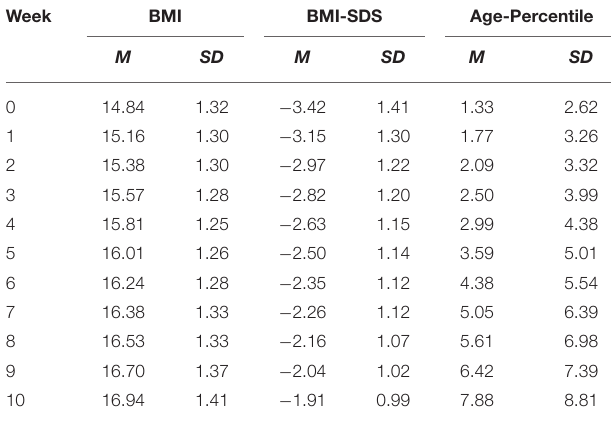
TABLE 3 | Descriptive